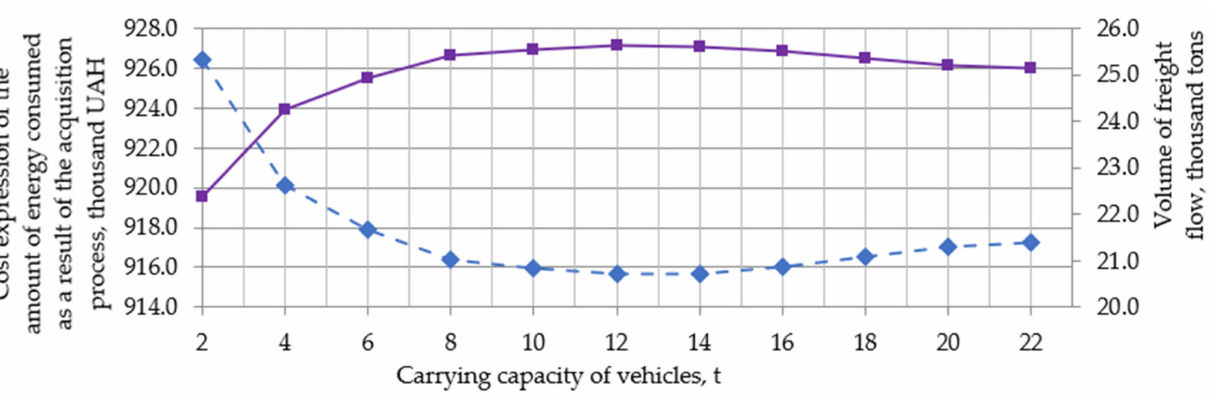
Figure 10. Changes in the cost expression of the amount of energy consumed due to the activity of acquisition in relation to the vehicle capacity: —freight flow according to the distribution scheme, thousand tons; —cost expression of the amount of energy consumed due to the activity of acquisition,